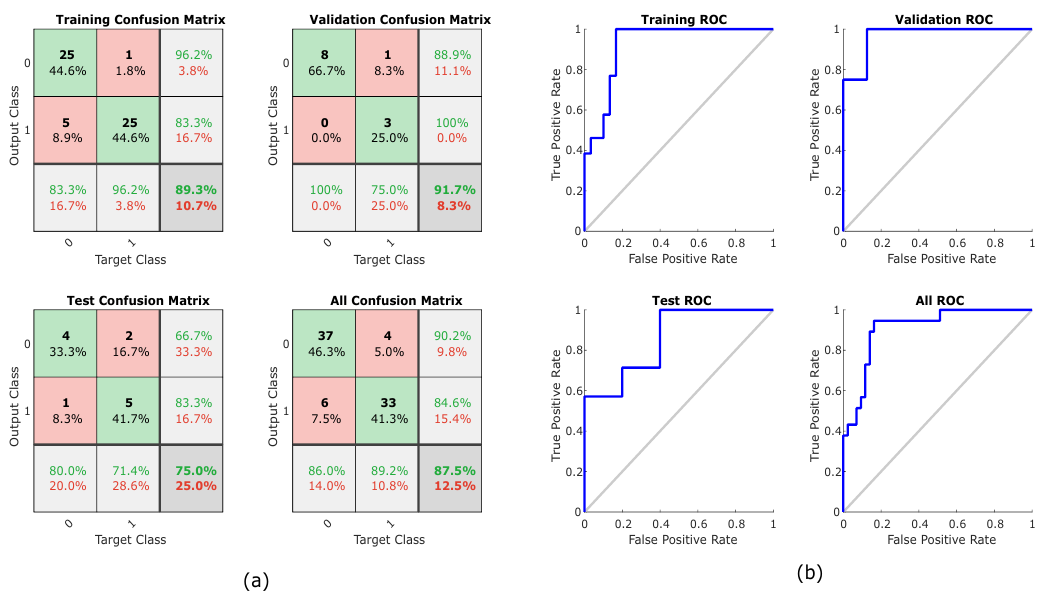
Figure 5. Neural networks training, testing, and validation using all causality measures: ( a ) confusion plot; and ( b ) receiver operating characteristic (ROC) curve.